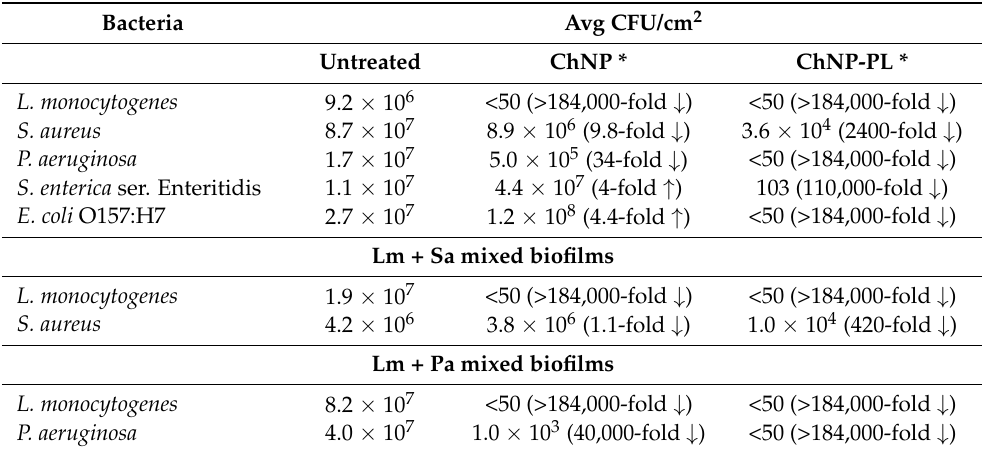
Table 3. Prevention of biofilm formation by chitosan nanoparticles. Bacteria Avg CFU/cm 2 Untreated ChNP